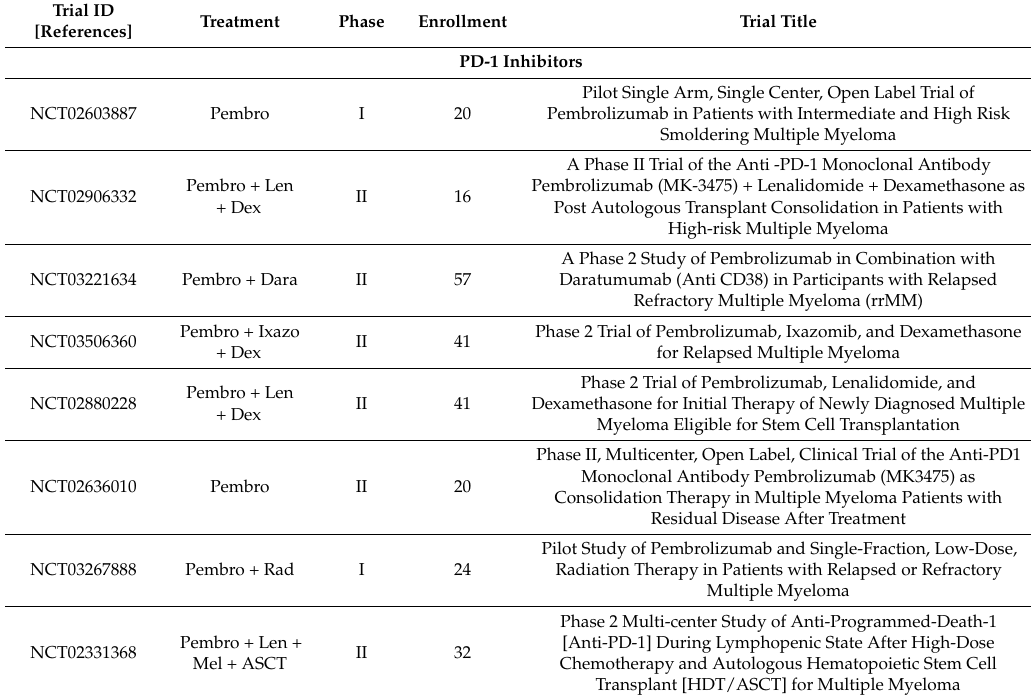
Table 4. Selected Trials of Checkpoint Inhibitors in MM a